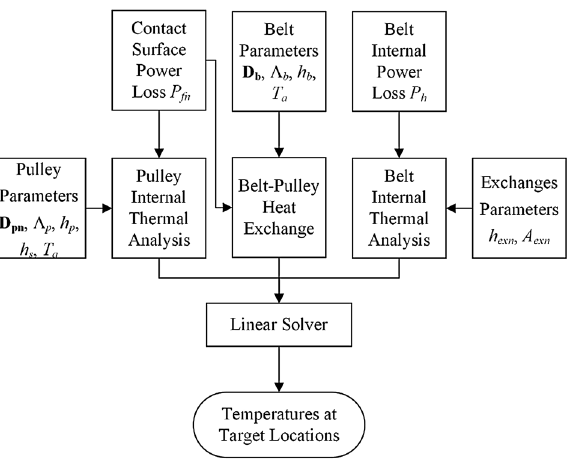
Figure 4. Flowchart of the